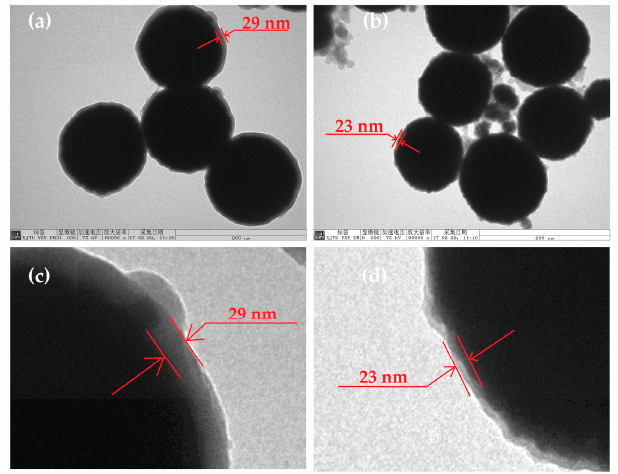
Figure 2. TEM images of the nanospheres (NSs) prepared: ( a ) Fe 3 O 4 @PDA NSs; ( b ) Fe 3 O 4 @PDA/Hyp NSs; ( c , d ) are the enlarged images corresponding to ( a , b ), respectively. Scale bar: 200 nm. Table 1. The DLS data of the NSs prepared. Paticle size NSs (nm)